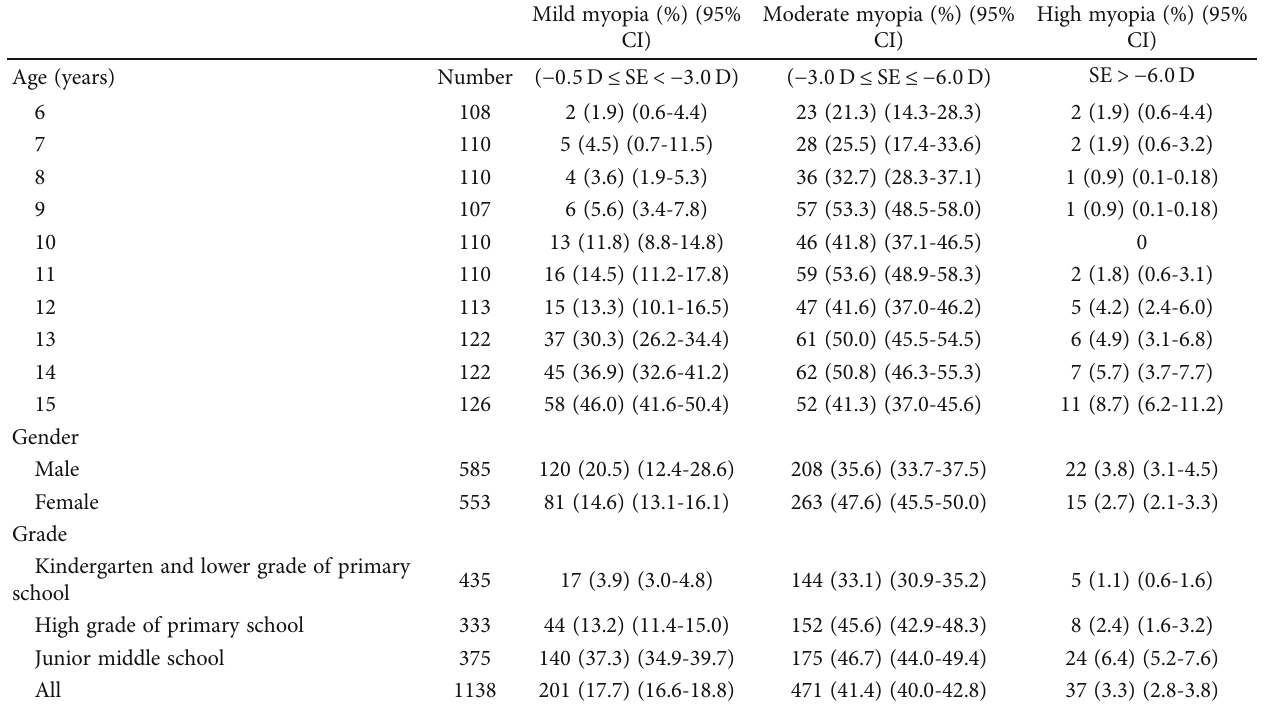
Table 5: Prevalence (%) (95% con fi dence interval) of mild myopia, moderate myopia, and high myopia strati fi ed by age, gender, and grade. Mild myopia (%)